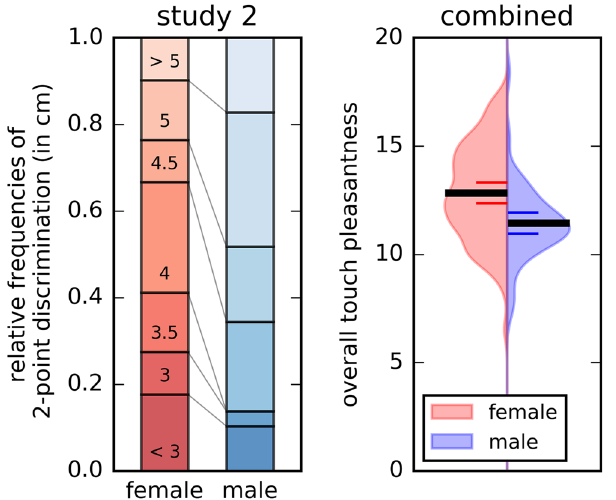
Figure 3. Two-point discrimination (study 2) and overall touch pleasantness (combined sample). Women present a lower two-point discrimination threshold then men. Touch pleasantness ratings were higher for women than men in the pooled data set (study 1 and 2). In the representation of overall touch pleasantness, the density is plotted on the x-axis. The black line represents the statistical mean value, the red and blue lines, respectively, represent 95% confidence intervals. The numbers and color codes on the bar representing the female values describe the distance of the two indenting stimuli in the course of the